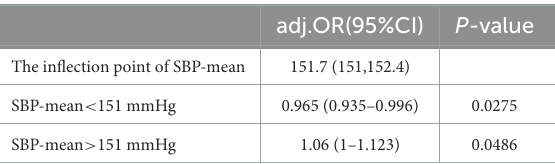
TABLE 4 Results of the two piecewise linear regression